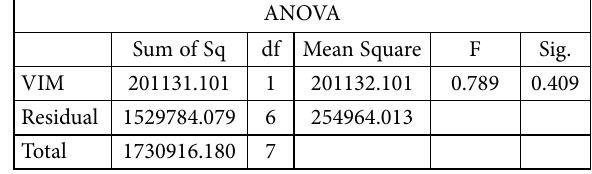
Table 7. Anova – VIM